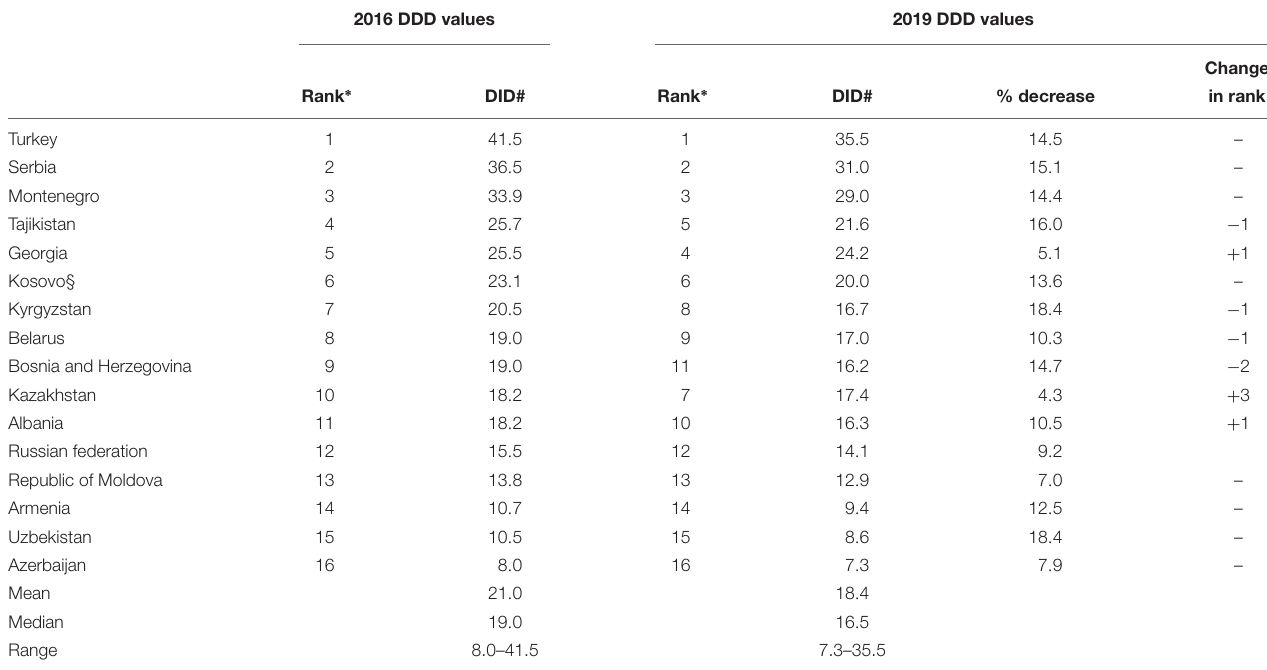
TABLE 2 | Impact of 2019 changes in DDDs on estimates of total antibiotic consumption and ranking of